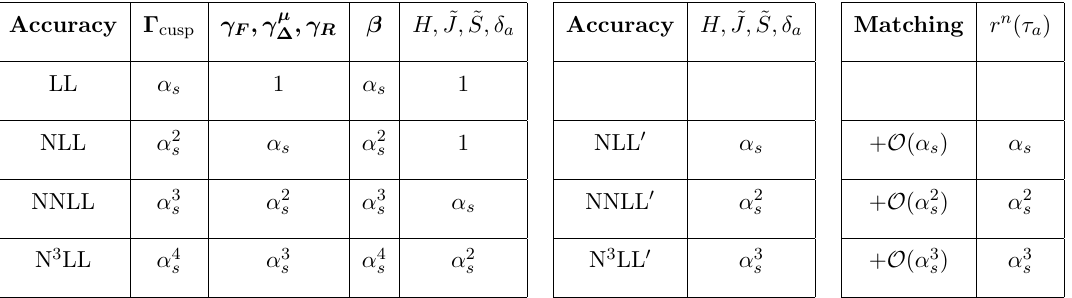
Table 6 . Ingredients we include at various orders of unprimed N k LL ( Left ), primed N k LL 0 ( Mid- dle ), and matched ( Right ) accuracies, up to a given (cid:12)xed order integrated distribution in eq. (4.38) and the Laplace-transformed distribution, but not, for unprimed accuracies, directly to the di(cid:11)erential form in eq. (2.1) | see [35] for details. We have included a counting for the renormalon subtractions terms (cid:14) a in eq. (4.12) and the (cid:22) - and R